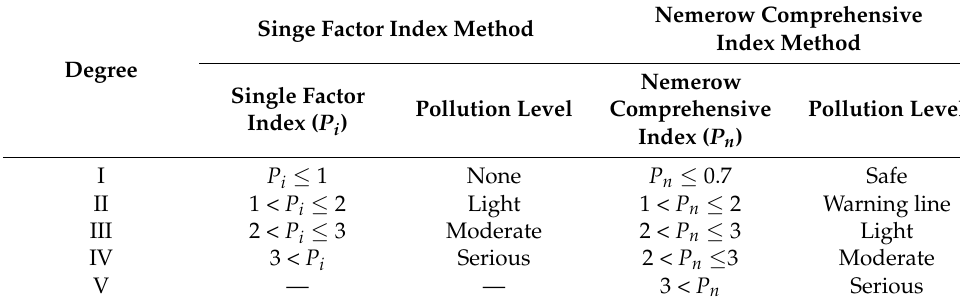
Table 3. The classification criterion of evaluation